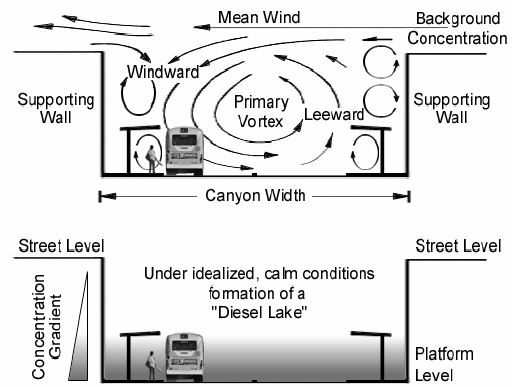
Figure 1 : Identical pollutant dispersion in a street canyon (modified [14]). The upper part of this picture shows strong wind conditions, which are capable to provide adequate ventilation and to remove air pollutants coming from the buses. The lower part depicts the most likely conditions in absence of wind or low ventilation favoring particle